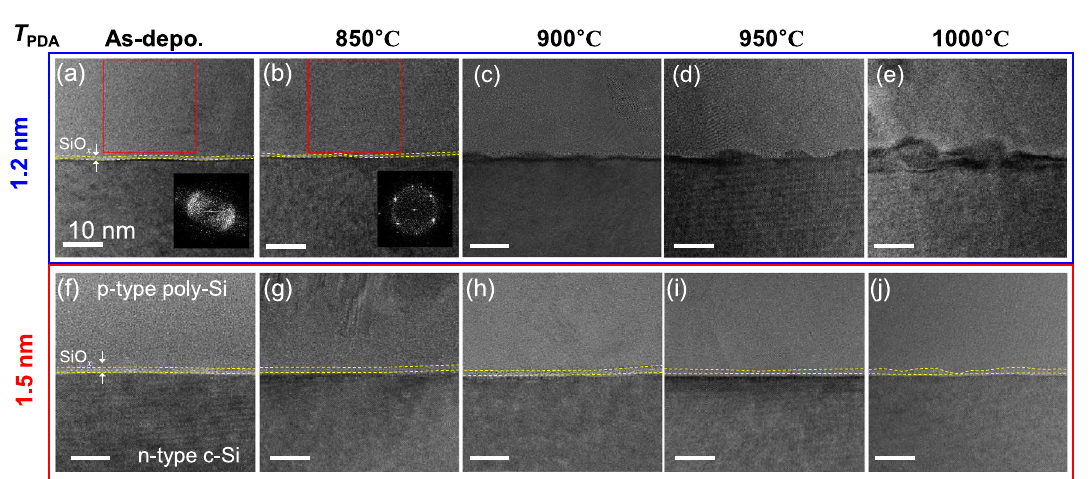
Figure 3. TEM images of the cross-sectional structures around the SiO x layers in as-deposited states, annealed at 850 °C, 900 °C, 950 °C, and 1000 °C for the samples with ( a )–( e ) 1.2-nm-thick SiO x layers and ( f )–( j ) 1.5-nm-thick SiO x layers. The FFT images in ( a ) and ( b ) were obtained from the red-boxed